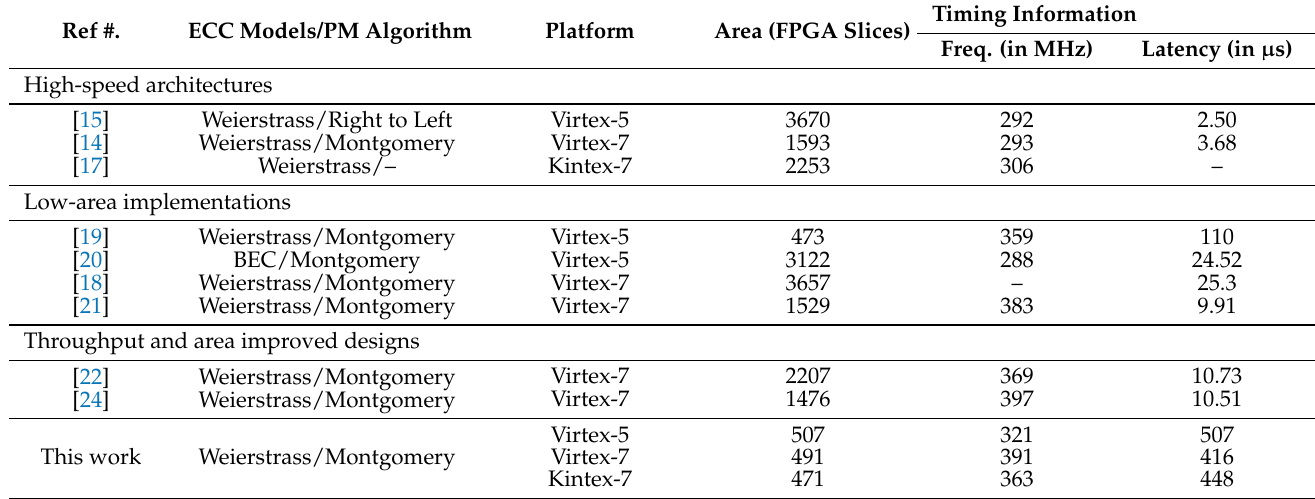
Table 2. Area and timing comparison with various existing architectures over GF ( 2 163 ) Ref #. ECC Models/PM